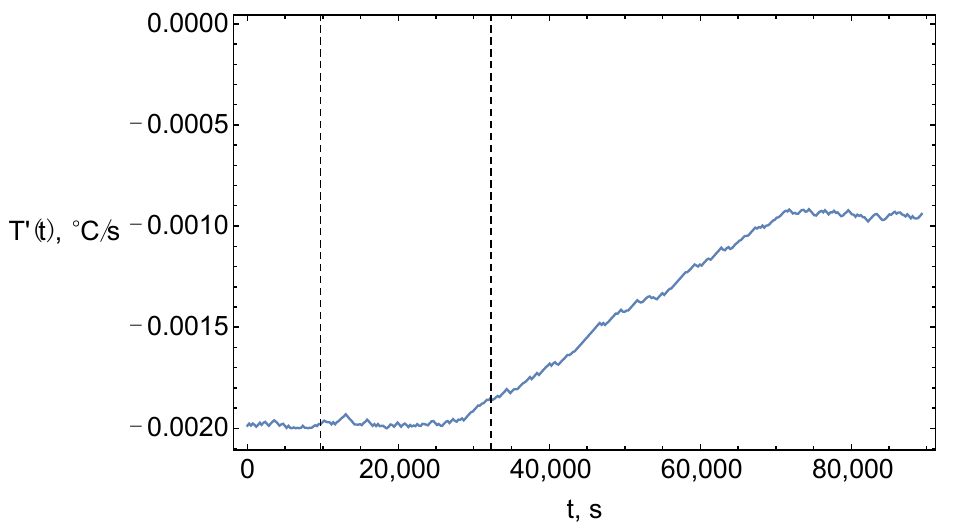
Figure 6. Obtained (cid:1846) (cid:1857)(cid:1876)(cid:1872)(cid:1870)(cid:1853)′ ( (cid:1872) ) for all three reactors (cid:1844)1, (cid:1844)2, and (cid:1844)3 ; vertical dashed lines represent extra times in each reactor.